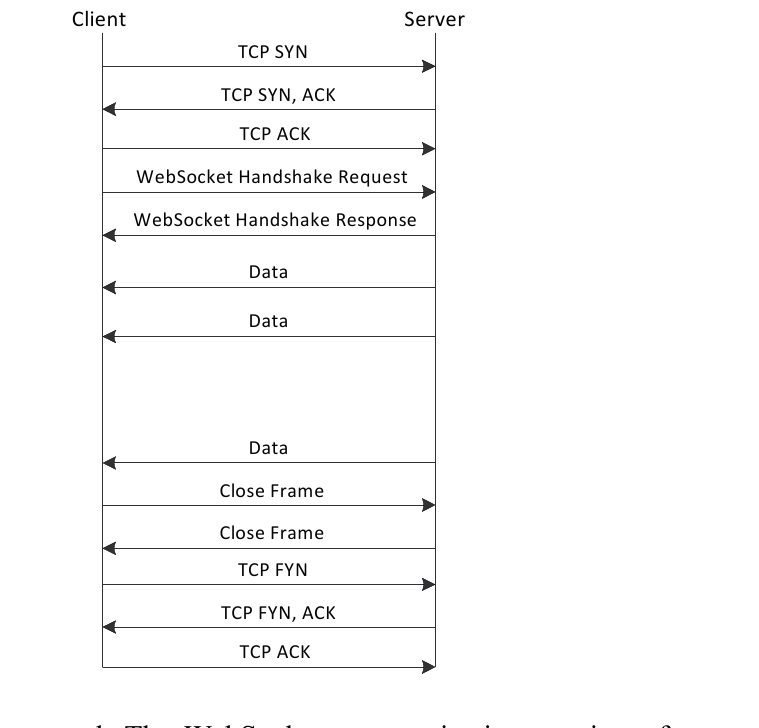
Figure 5. WebSocket protocol. The WebSocket communication consists of an opening handshake, a data transfer and a closing